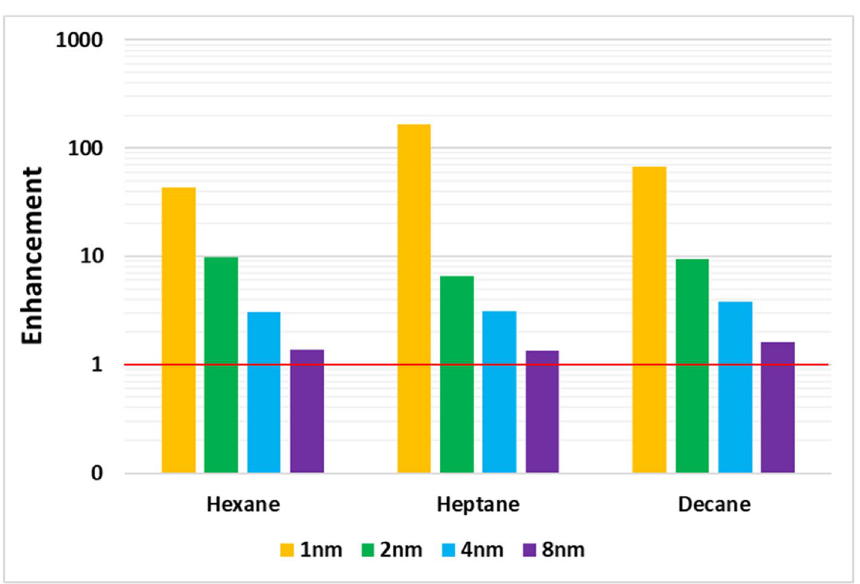
Figure 6. Enhancement factor for the flow of hydrocarbons in different sizes of CNT. The redline indicates no enhancement (i.e. following Hagen Poiseuille